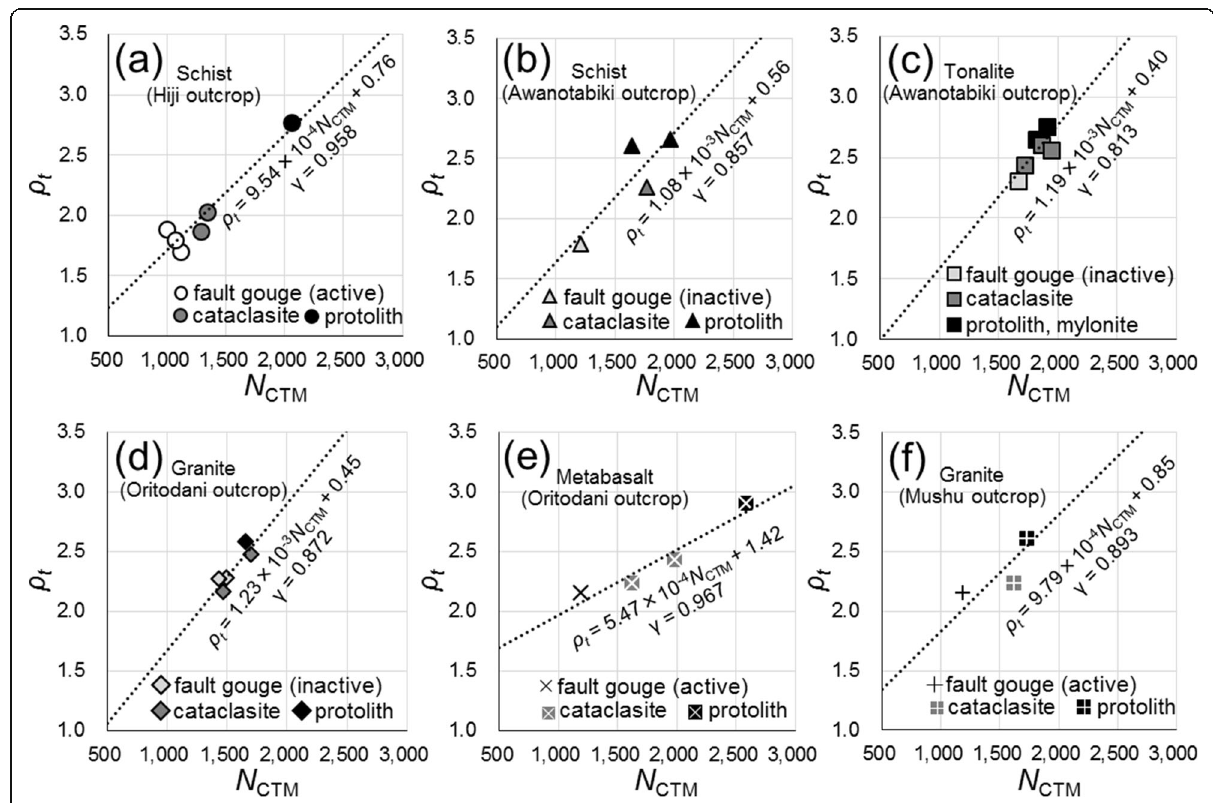
Fig. 10 ρ t – N CTM crossplots for the sampled fault rocks and protoliths. a Schist (Hiji outcrop). b Schist (Awano – Tabiki outcrop). c Tonalite (Awano – Tabiki outcrop). d Granite (Oritodani outcrop). e Metabasalt (Oritodani outcrop). f Granite (Mushu